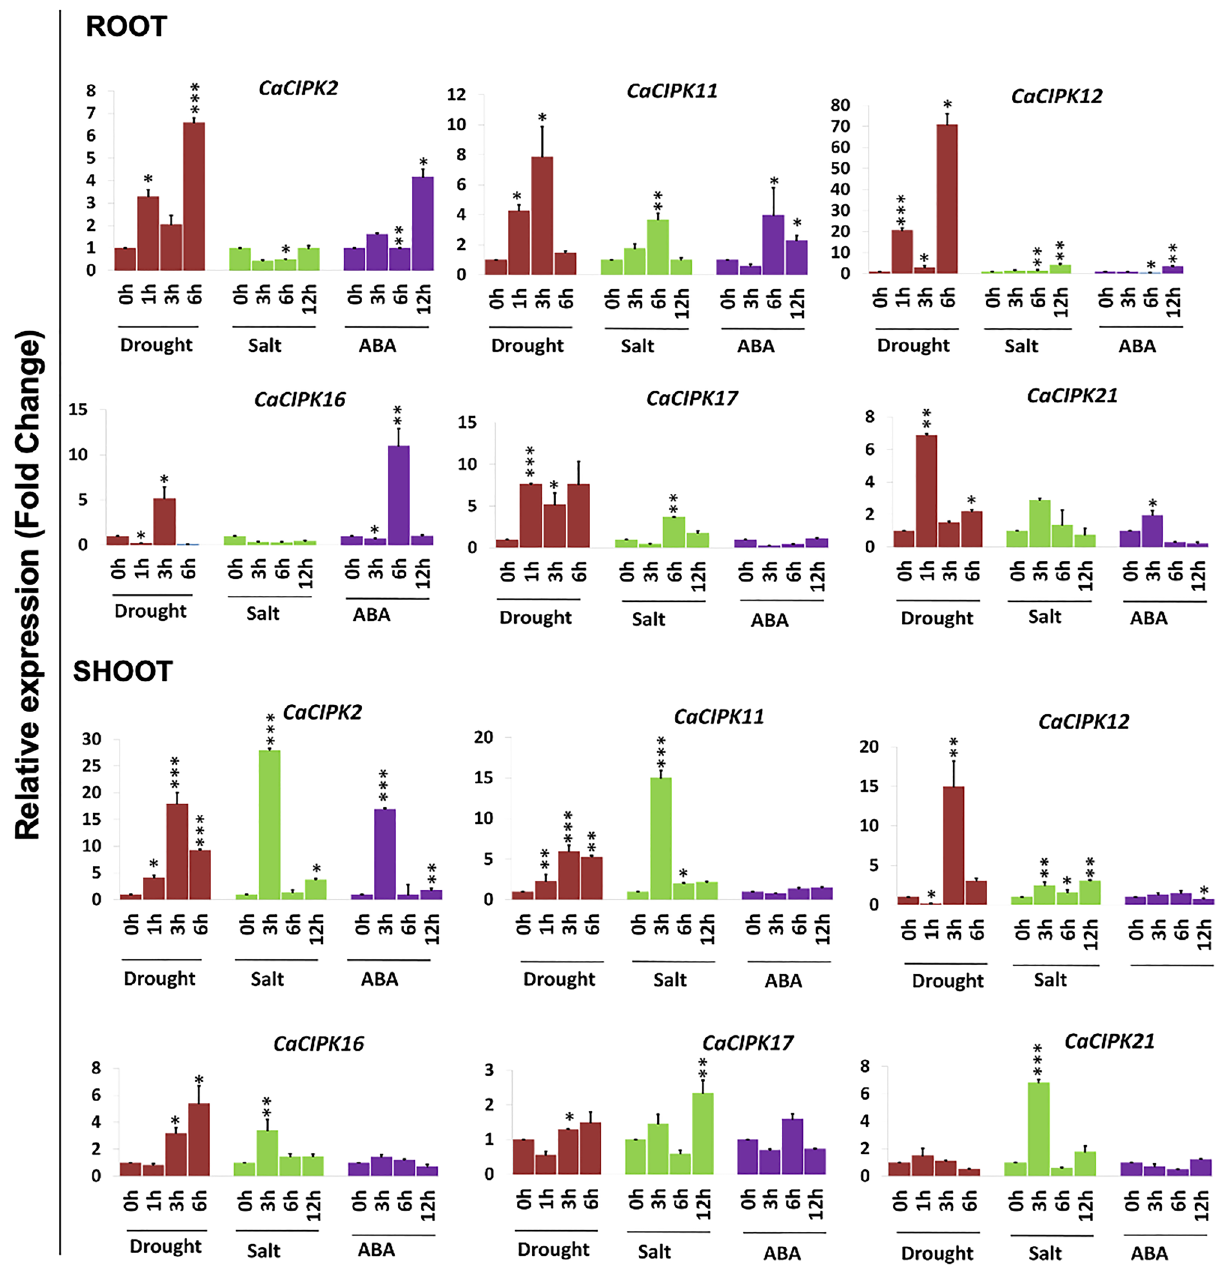
Figure 10. Expression profiles of CIPK genes under drought, salt and ABA treatments in chickpea. qRT- PCR analysis was performed to generate the expression profile of CaCIPK genes under drought, salt and ABA treatment in root and shoot of desi chickpea (ICC4958). Different treatments and time points are indicated on X-axis and relative expression level of gene is indicated on Y-axis. Each bar represents mean value of three replicates. Standard error among the samples is indicated by error bars. * represents p -value < 0.05, ** p -value < 0.01 and *** p -value < 0.005 for treated samples w.r.t. untreated